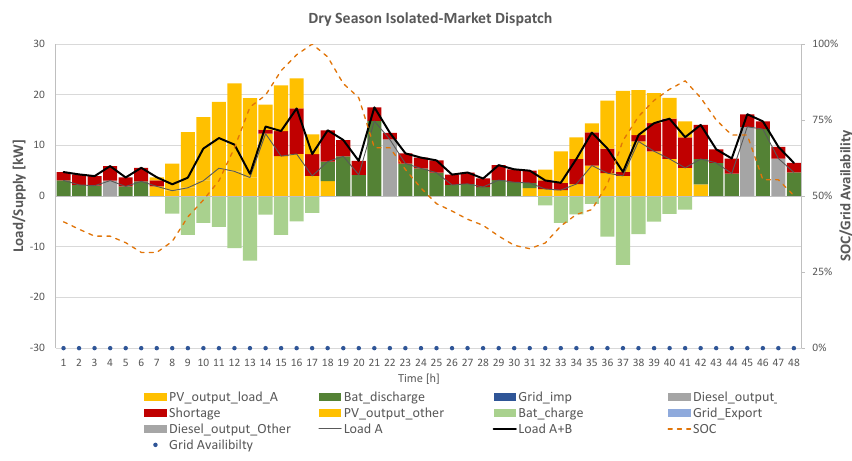
Figure 19. Market–based optimal dispatch for dry season off-grid mini-grid. In order to allow for a direct more equal comparison of the dispatch strategies by the HOMER Pro PS and the market-logic approach, we performed an additional simulation, shown in Figure 21, of the market-logic approach assuming a regulatory, not market- driven, constraint of 100% reliability for Loads A and B. The comparison still shows the cost advantage of our proposed model against the predictive dispatch approach provided by HOMER PS in Figure 20 (see also Table 6). Although under the market-logic strategy, the DG runs in a less optimal operation mode than in HOMER PS, the market dispatch avoids that the DG charges the battery. The market dispatch makes the more adequate choice to only charge the battery with solar as the DG is always available as back-up. In fact, the comparison with HOMER PS could be done for the isolated scenario as HOMER’s predictive strategy does not allow to model a grid-connected MG. The latter shows a further advantage of our proposed model, which allows for the consideration of isolated MG, UMG and a reliable and unreliable grid connection.